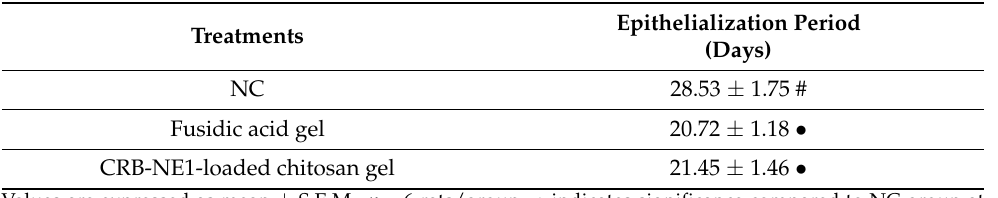
21.45 ± 1.46 ● Values are expressed as mean ± S.E.M., n = 6 rats/group. ● indicates significance compared to NC group at p < 0.05. # indicates significance compared to fusidic acid gel group at p < 0.05.